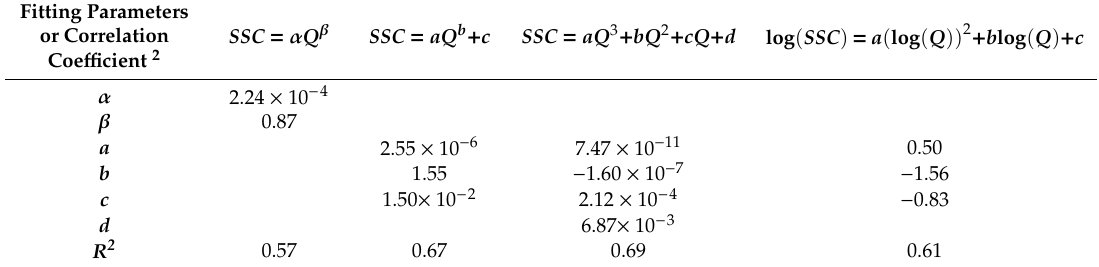
Table 3. Sediment rating curves with di ff erent formulas 1 .